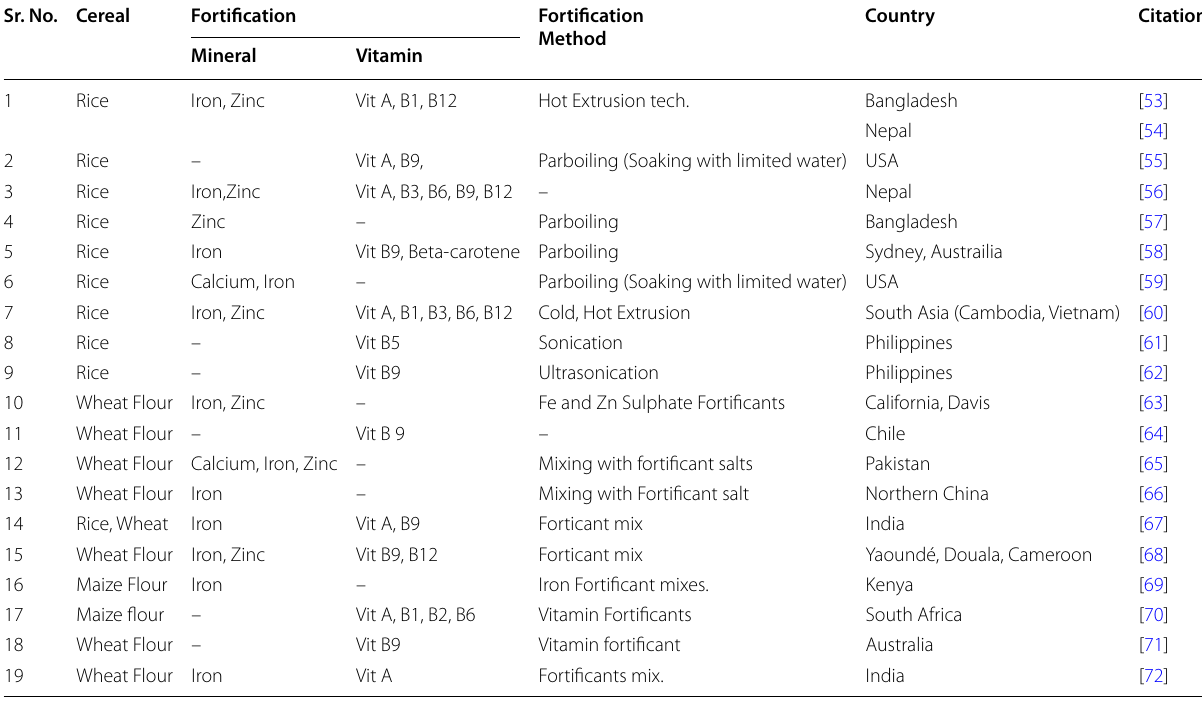
Table 1 Cereals Fortification with Vitamins & Minerals Sr. No.